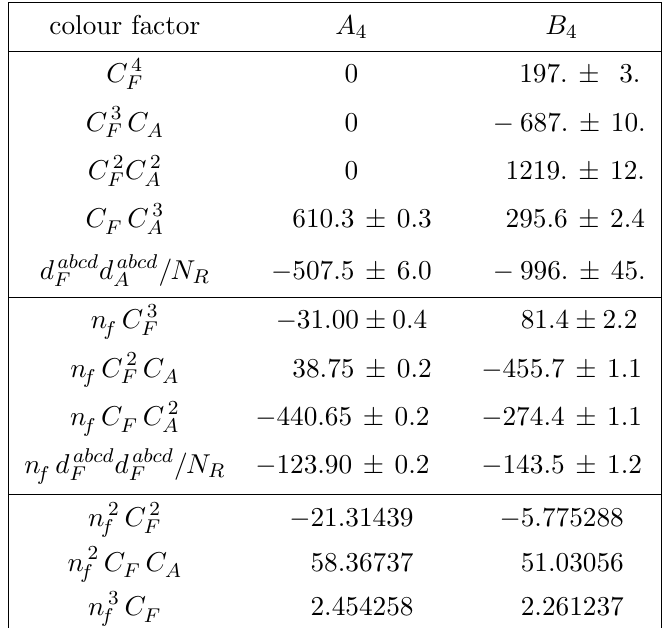
Table 2 . Numerical results for the large- x coe(cid:14)cients A 4 and B 4 for the seven colour factors contributing to the n 0 are